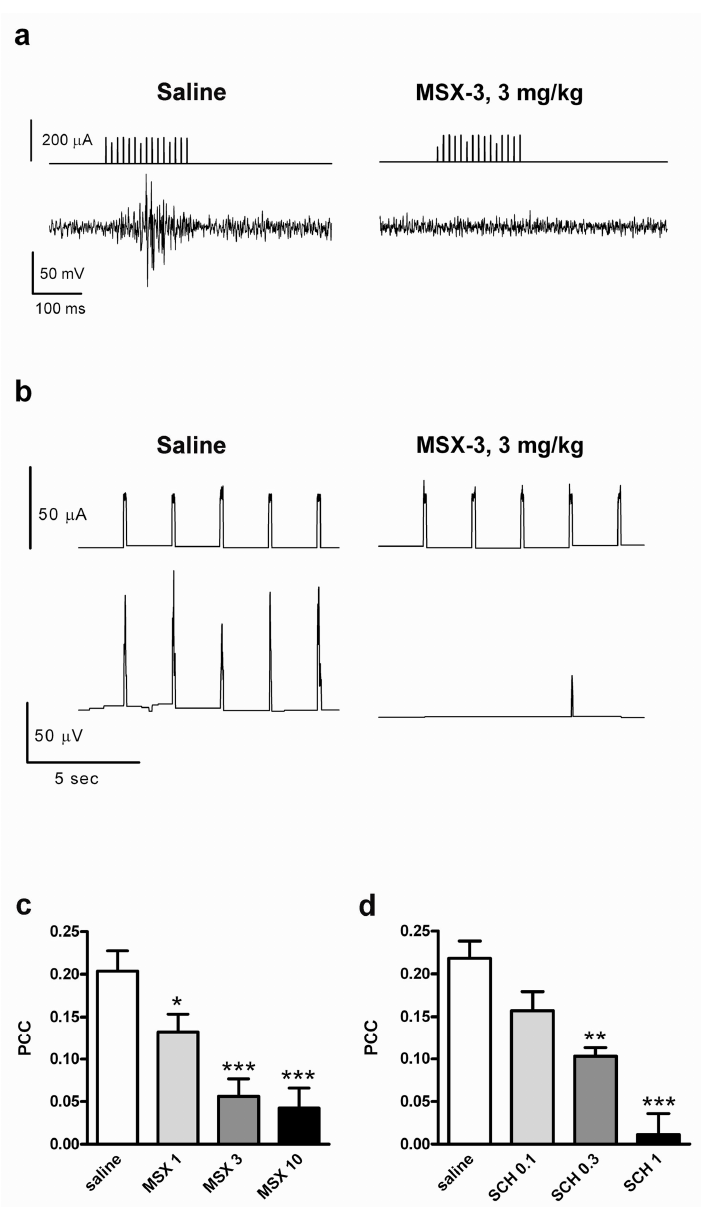
FIGURE 8. A 2A receptor antagonist–induced blockade of the motor output induced by cortical electrical stimulation. (a) Representative recordings of the input signal (current pulses) delivered from the stimulator in the orofacial area of the motor cortex (upper traces) and the EMG output signal obtained from the jaw muscles (lower traces), after the administration of either saline (left traces) or the A 2A receptor antagonist MSX-3 (3 mg/kg, i.p.; right traces). (b) Representative input stimulator signal power (time constant 0.01 sec; upper traces) and output EMG signal power (time constant 0.01 sec; lower traces) after the administration of either saline (left traces) or MSX-3 (right traces). (c,d) Dose-dependent decrease in the PCC of the power of input and output signals induced by the administration of MSX-3 (c) and the D 1 receptor antagonist SCH23390 (d). Results represent means ± SEM (n = 6–8 per group); *, **, ***: significantly different compared to saline ( p < 0.05, p < 0.01, and p < 0.001,